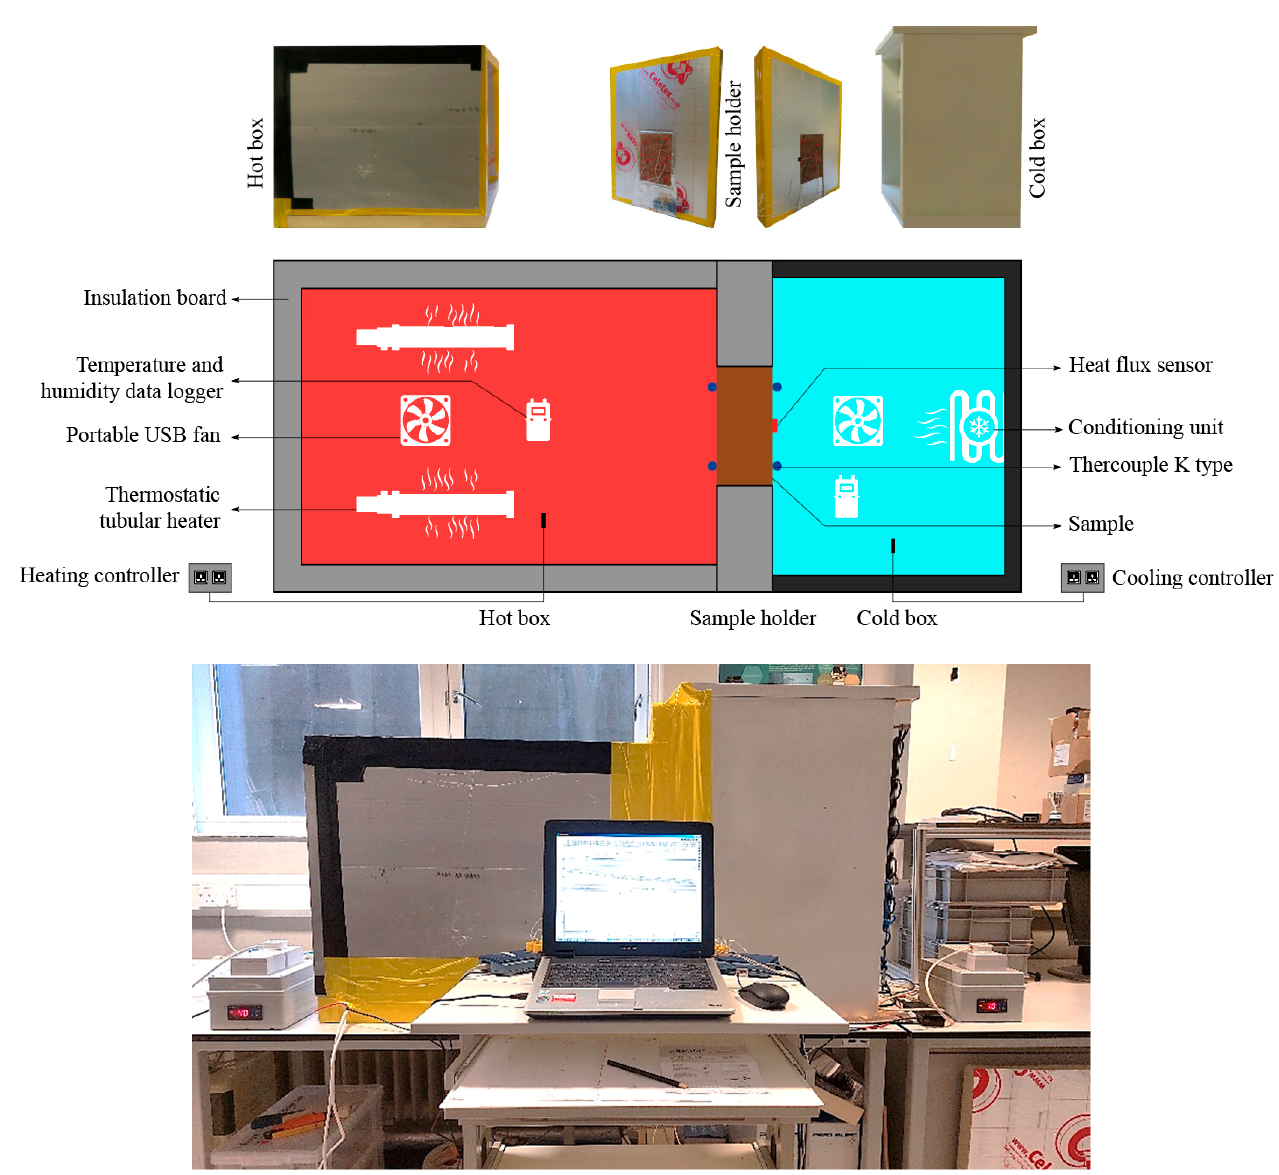
Figure 6. Test setup of thermal transmittance measurement. The surface temperature of the sample wall was measured using thermocouple K-type sensors attached to the sample wall. On either side of each block of the sample wall, two thermocouple K sensors were installed. In addition, two heat-flux sensors (gSKIN-XB 26 9C) were installed on the sample wall facing the cold room (Figure 7). In order to prevent any influence of air gaps, sandpaper was used to smooth the wall surfaces where the sensors were installed, and adhesive tape was used to fix the sensors to the wall, ensuring that all sensors had good thermal contact with the wall surface. All the sensors were connected to a data logger (Pico USB TC-08) to record the continuous readings for 3 days (72 h),